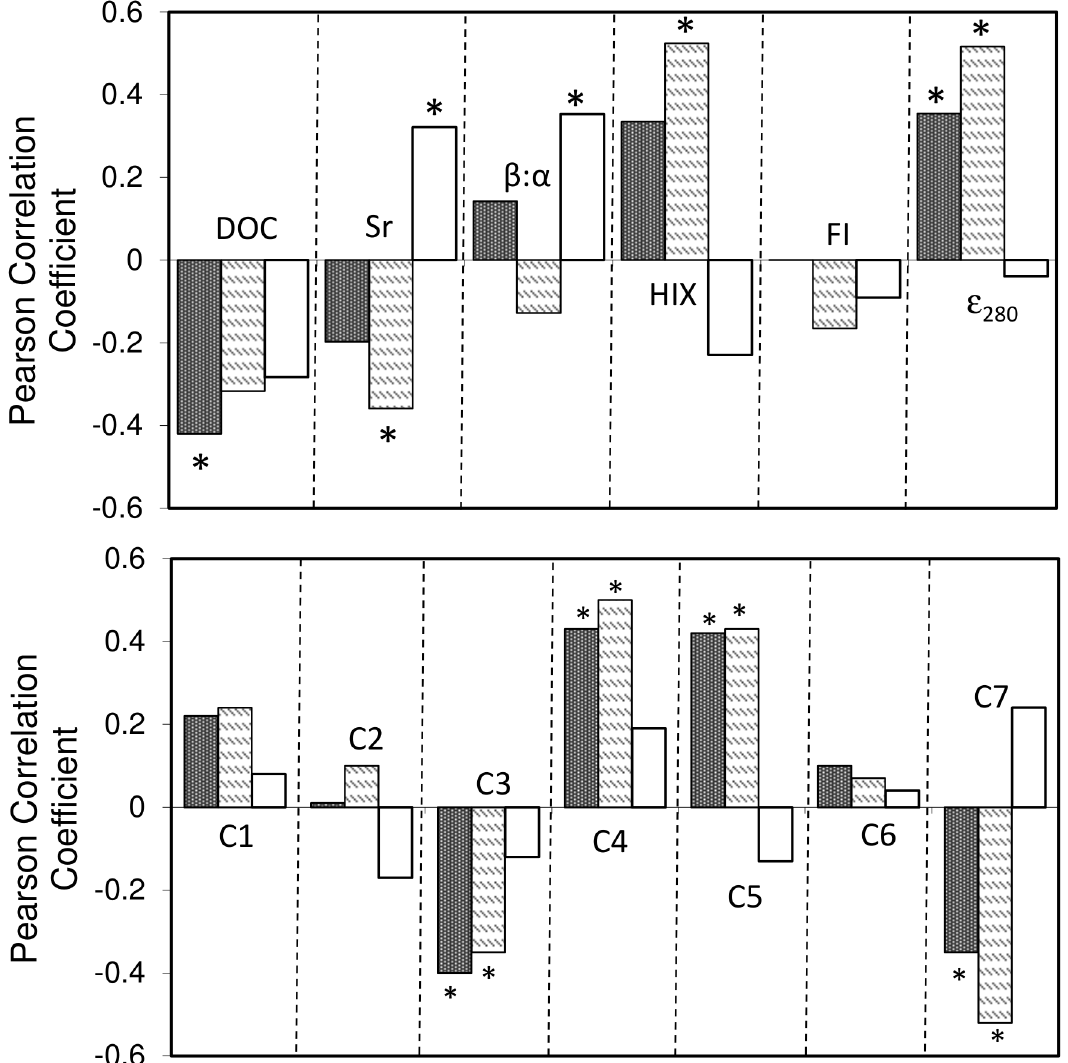
Figure 6. Correlation coefficients between DOC concentration (mg C L -1 ), optical properties, and PARAFAC components and seston chlorophyll (dark bars), TP (light bars) and DO (open bars). Significant correlations ( p <0.05) are noted with *. doi: